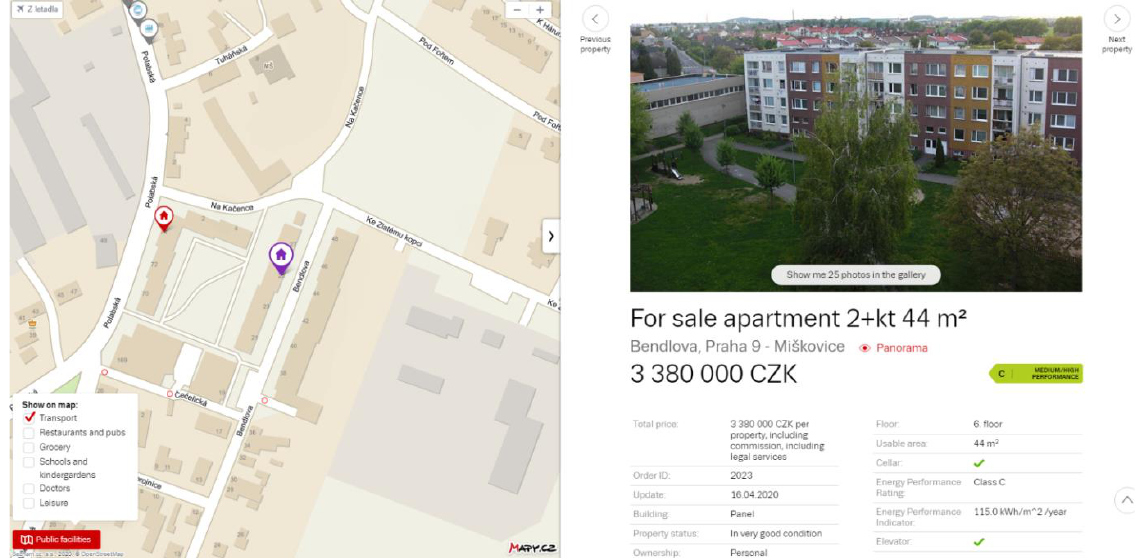
Figure 1: Example of bid advertisement and available information (source: